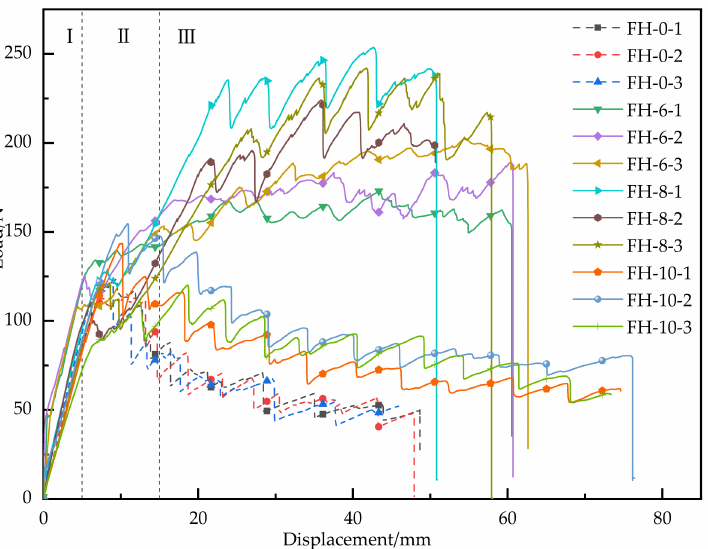
Figure 6. Load–displacement response of GFRP/foam sandwich composite specimens using CSB